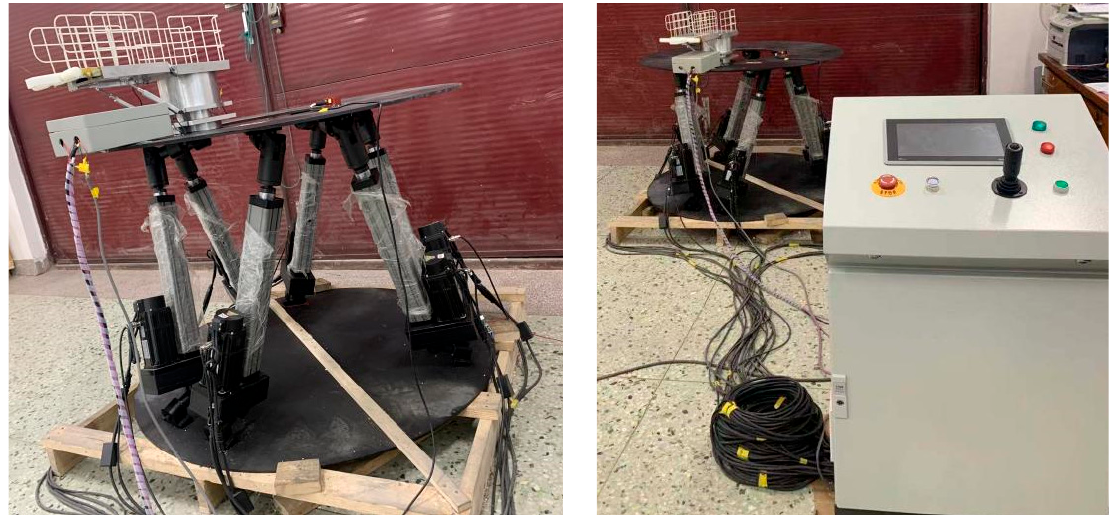
Figure 15. 6-DOF motion platform.